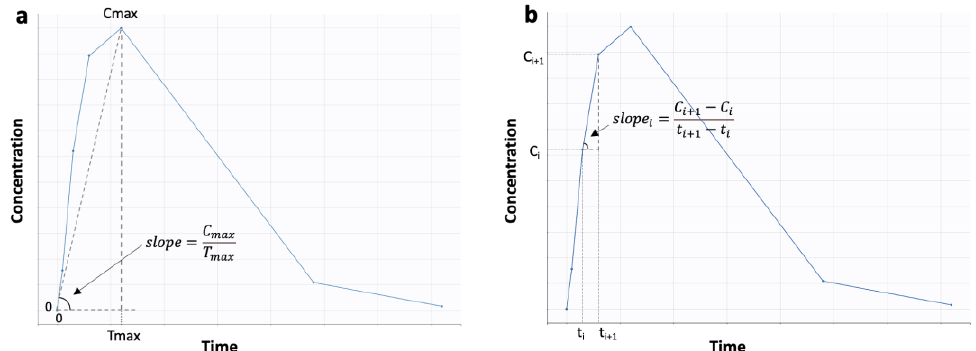
Figure 1. Graphical illustration of the Cmax/Tmax ratio and average slope. ( a ) The Cmax/Tmax ratio is the slope defined as the tangent of Cmax to Tmax. ( b ) The average slope is the average of all individual slopes (i.e., slope i ) formed between two consecutive time points up to Tmax.